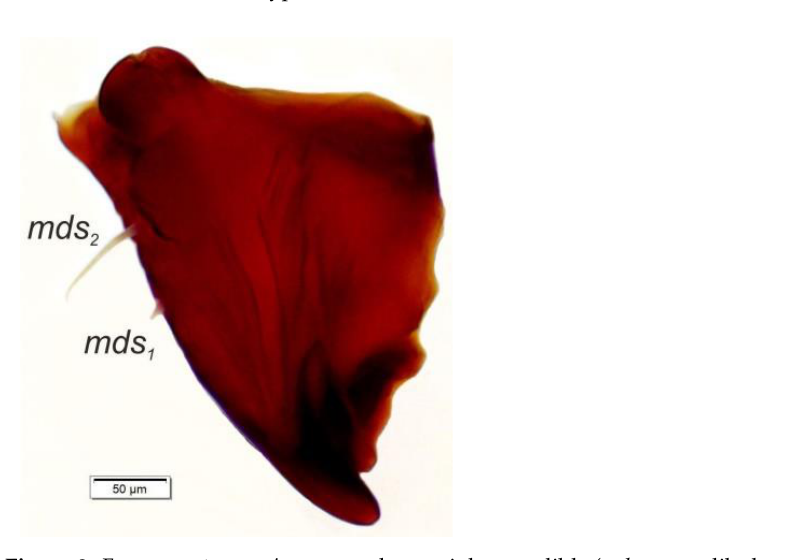
Figure 9. Euryommatus mariae mature larva, right mandible ( mds —mandibular seta).